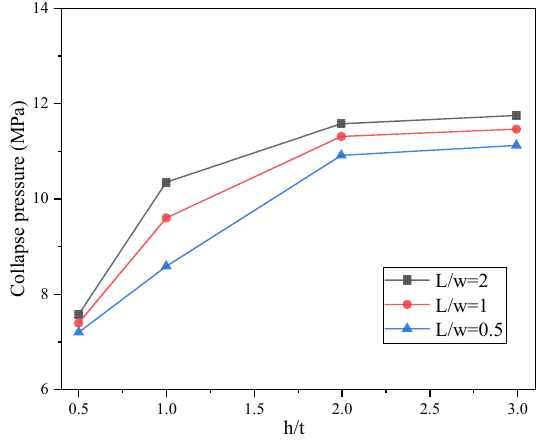
Figure 24. Influence of CFRP thickness on the repair effect.